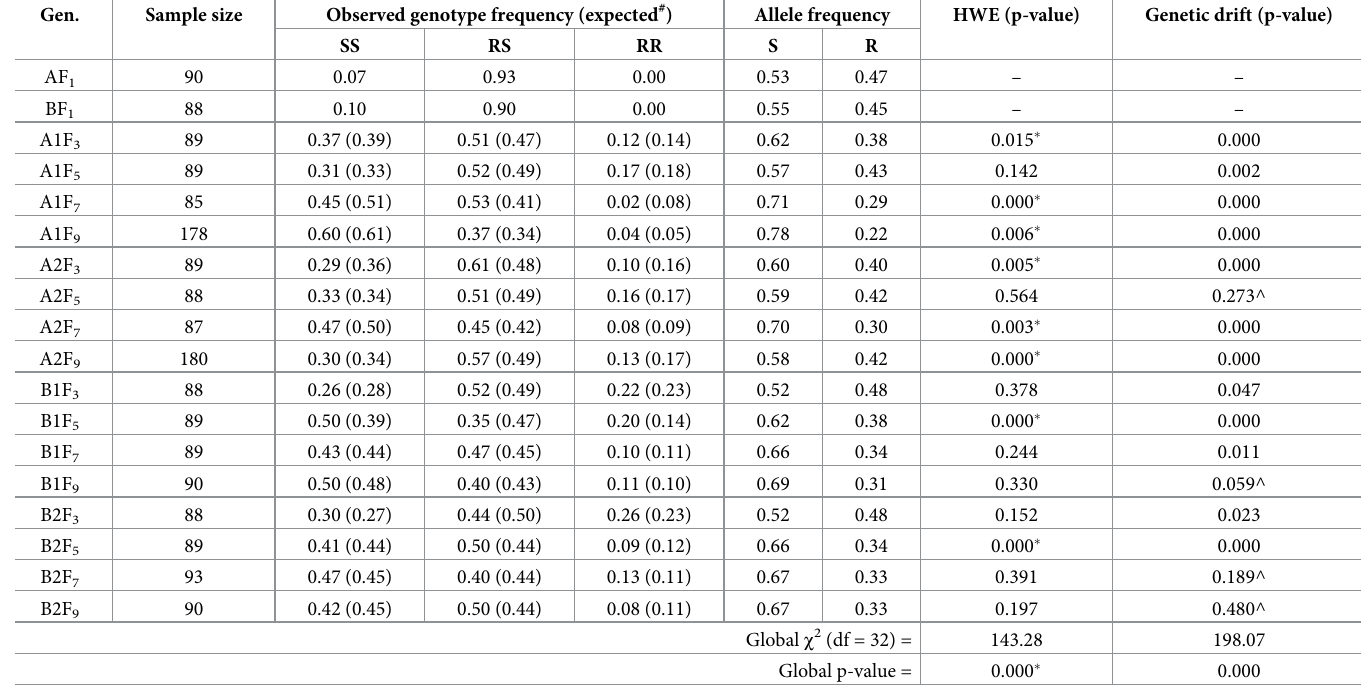
Table 2. Genotype and allele frequencies for each replicate of the KR x ROCK experiment and their associated Hardy-Weinberg (HWE) and genetic drift p-values. Gen. Sample